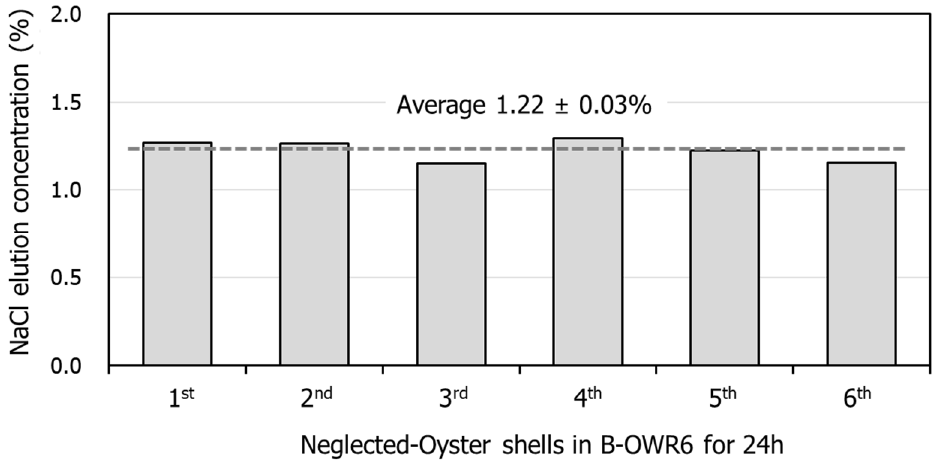
Figure 1. NaCl content of neglected oyster shells in B-OWR6 for 24 h.